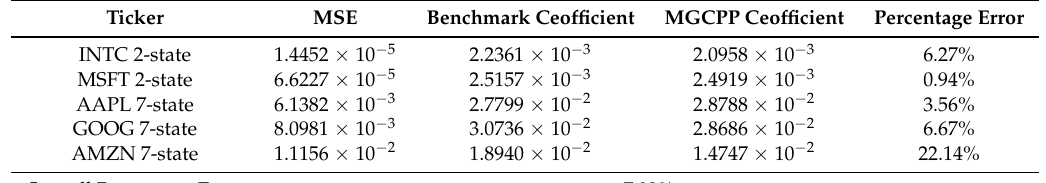
Table 9. The MSE and coefficients computed by MGCPP FCLT